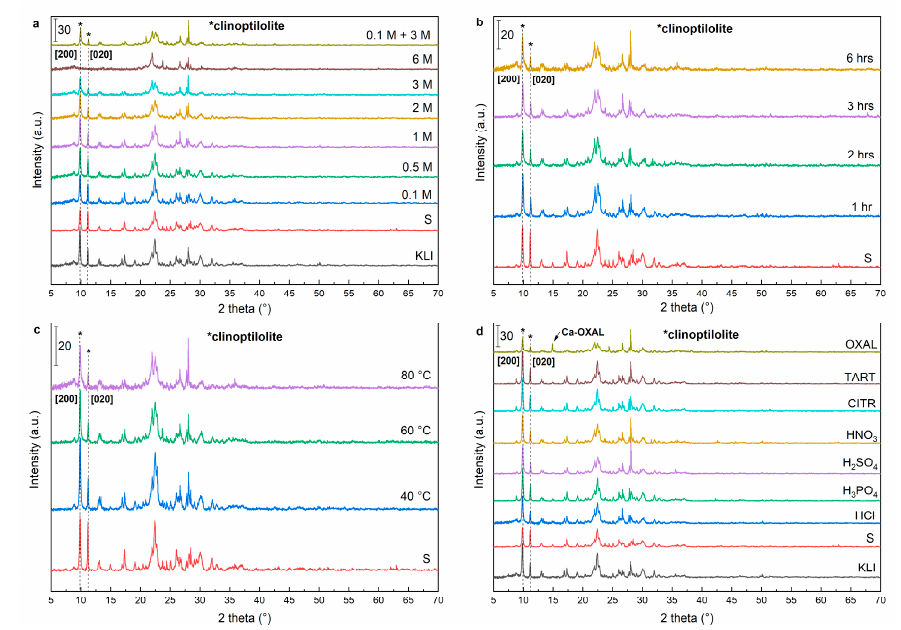
Figure 2. Powder di ff raction patterns of modified foams: Influence of acid concentration ( a ), time ( b ), temperature ( c ), and type of acid ( d